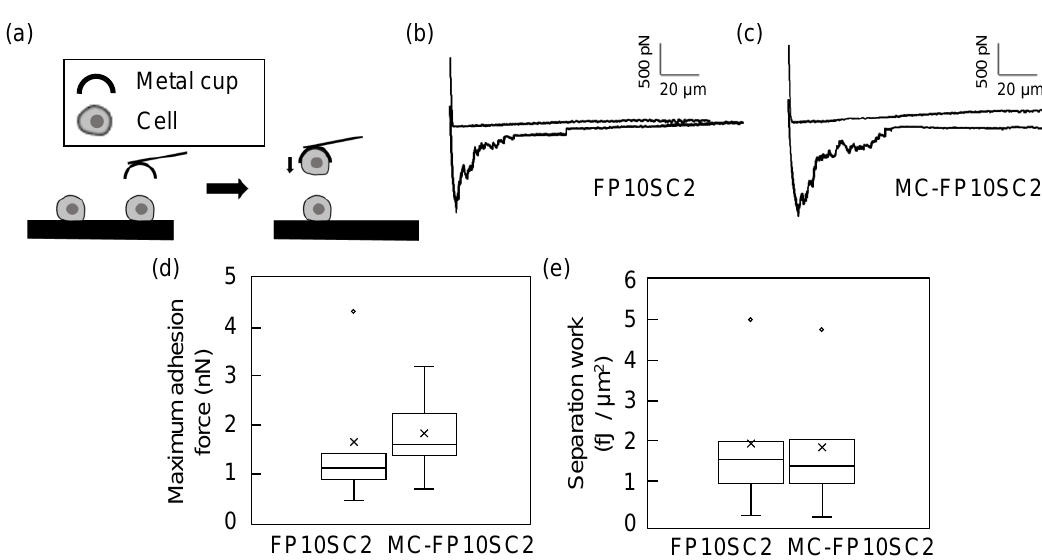
Figure 5. Measurements of changes in intercellular adhesion strengths. ( a ) Experimental design of the measurement system. A cancer cell was picked up using the cup-chip in the AFM, brought closer to another cancer cell, and force measurements were carried out. ( b , c ) Typical force curves obtained at the separation between two FP10SC2 cells (b) and two MC-FP10SC2 cells (c). ( d , e ) The boxplots of maximum adhesion forces (d) and separation work (e) of FP10SC2 and MC-FP10SC2 cells. P < 0.01 for (d).